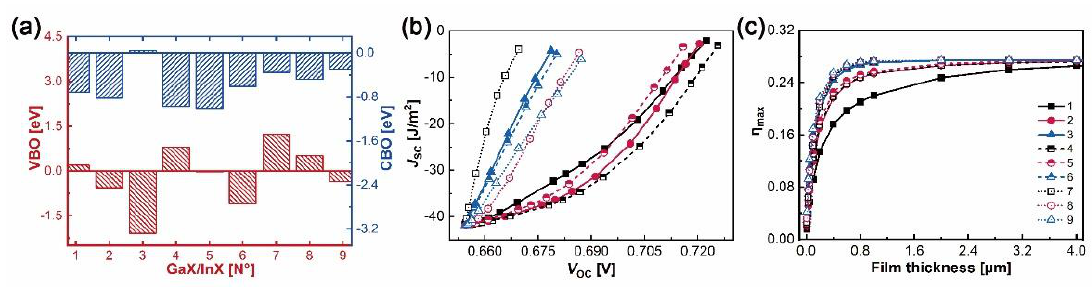
Figure 7. ( a ) Valence (red color) and conduction (blue color) band offsets; ( b ) calculated J SC -V OC curves and ( c ) conversion efficiency η max under AM 1.5G illumination at different film thicknesses of GaX/InX.